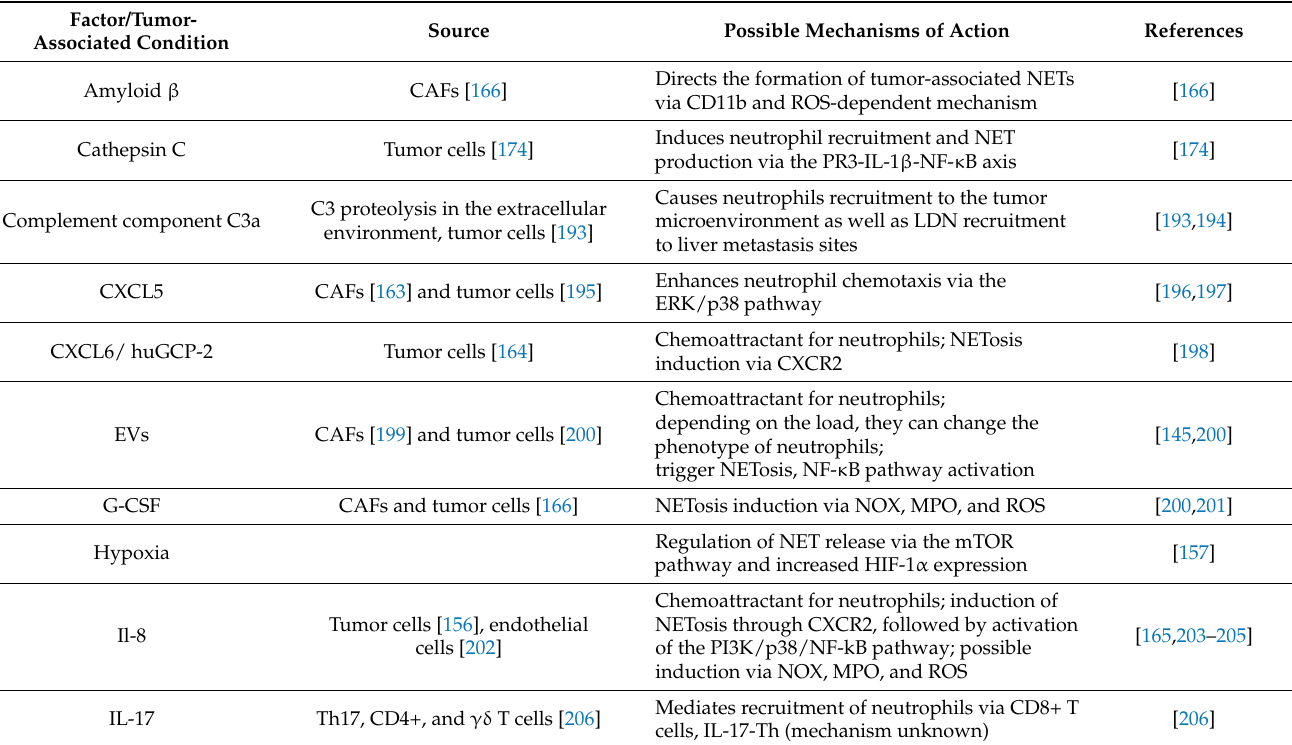
Table 2. Tumor-derived factors inducing